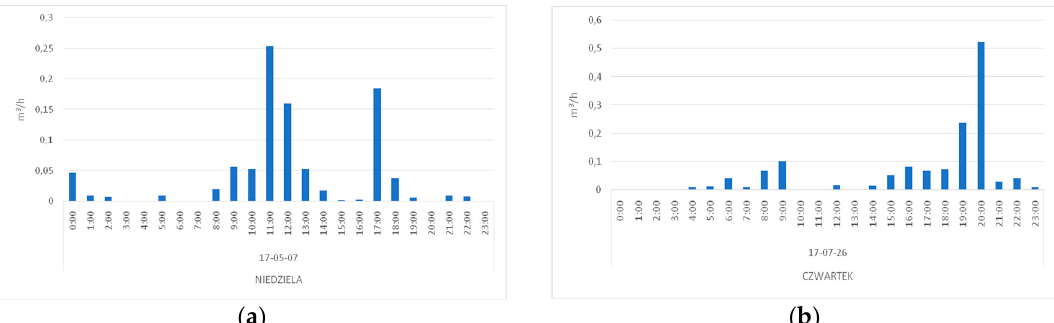
Figure 3. Examples of variability of hourly water consumption in a day with maximum demand in selected single-family houses: ( a ) building no. 1, ( b ) building no.